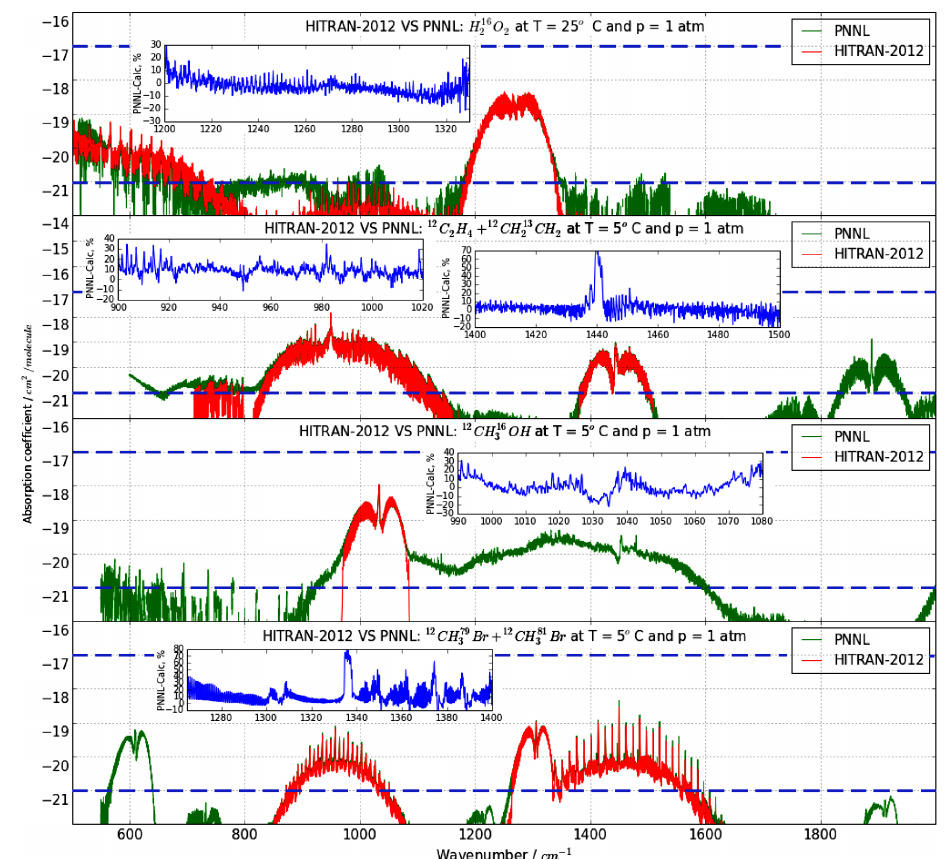
Figure 2. Comparison of HITRAN with PNNL: from top to bottom H 2 O 2 , C 2 H 4 , CH 3 OH, CH 3 Br. The area inside the thick dashed horizontal grid lines corresponds to the area shown in the panels of Fig. 1 in the BG